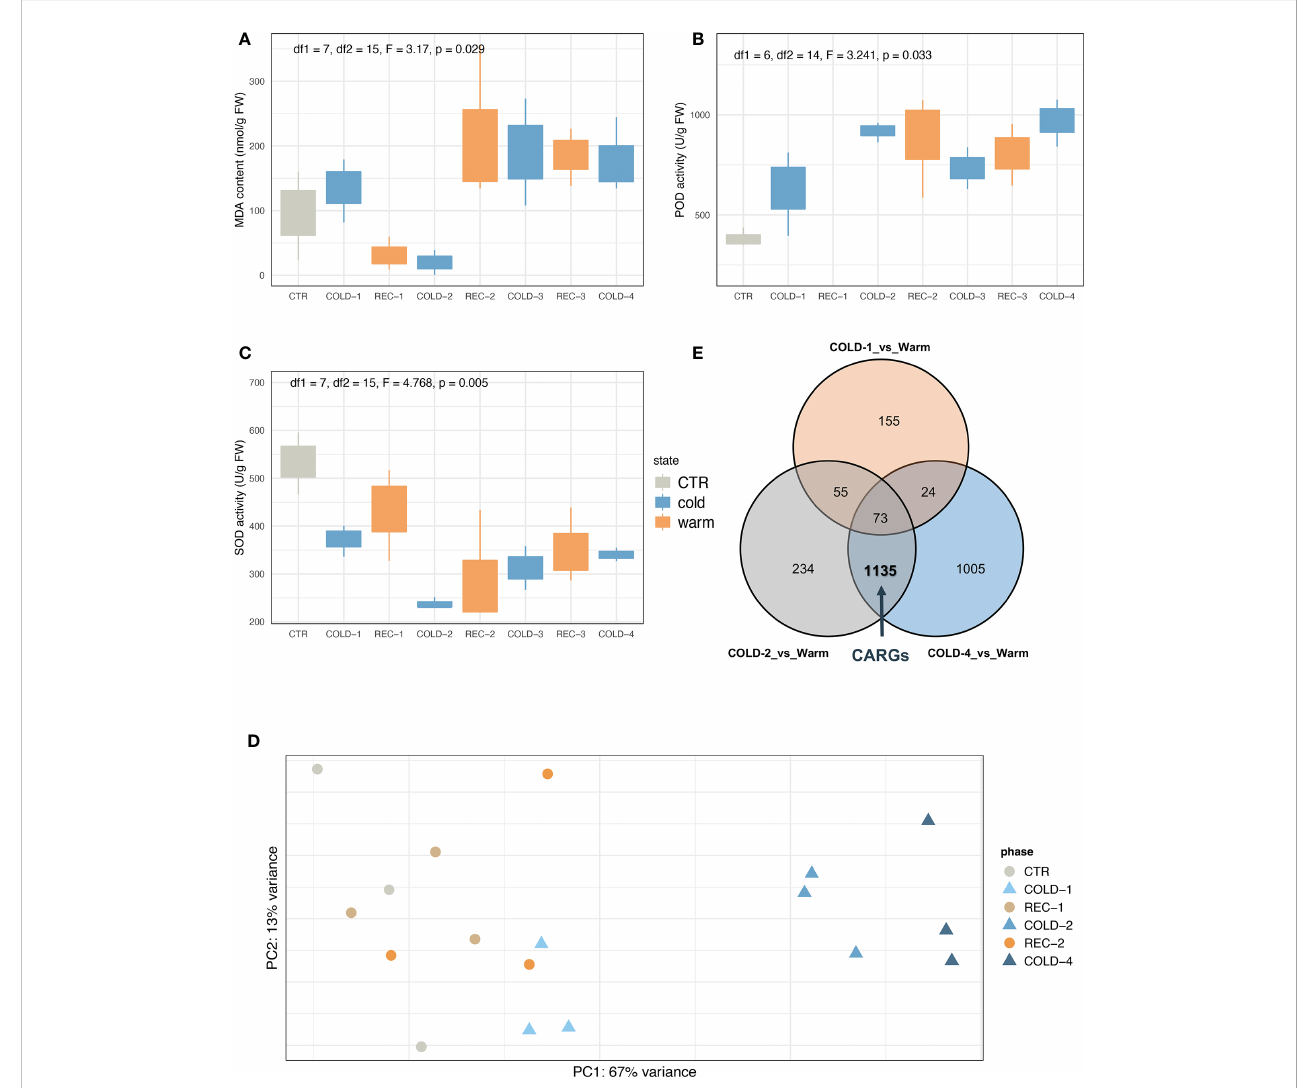
FIGURE 2 Physiological and transcriptomic responses of K. obovata seedlings to circles of cold and recovery. Enzyme activity changes of malondialdehyde (MDA) (A) , peroxidase (POD) (B) , and superoxide dismutase (SOD) (C) . (D) PCA results of transcriptome analysis. Circles mean warm conditions (CTR and REC-1/ 2), triangles mean cold treatments (COLD-1/2/4). (E) The Veen plot of 2,681 DEGs between the cold treatments (COLD-1/2/4) and the warm conditions (CTR and REC-1/2). The bold value represented the number of cold acclimation related genes (CARGs). The de fi nition of CARGs was based on the analysis results of DEGs. CTR, REC-1, and REC-2 were set as ‘ Warm ’ status, genes differentially expressed (|log2FoldChange| > 2 and padj < 0.01) between COLD-1/Warm versus COLD-2/Warm or COLD-4/Warm were named